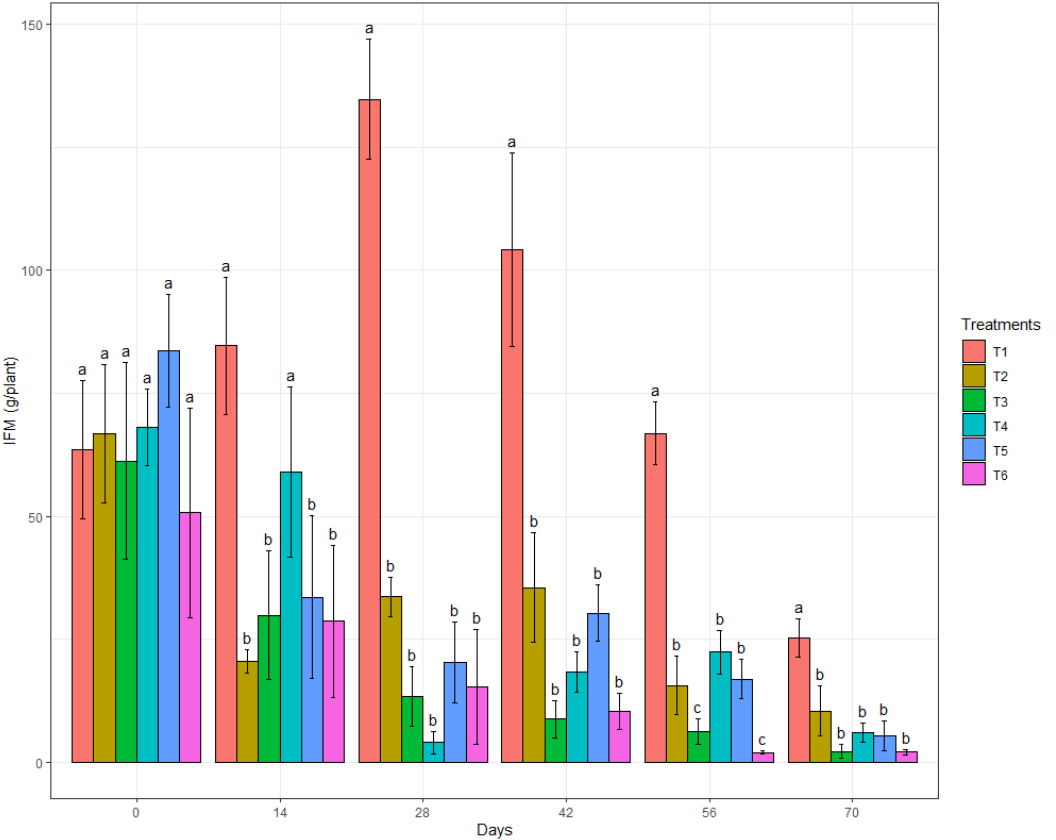
Figure 4. Mean IFM of the treatments (T1: water; T2: chemical control; T3: biological control; T4: B.BV10 1 g/L; T5: B.BV10 2 g/L; and T6: B.BV10 4 g/L) at each time of evaluation. Means in each day